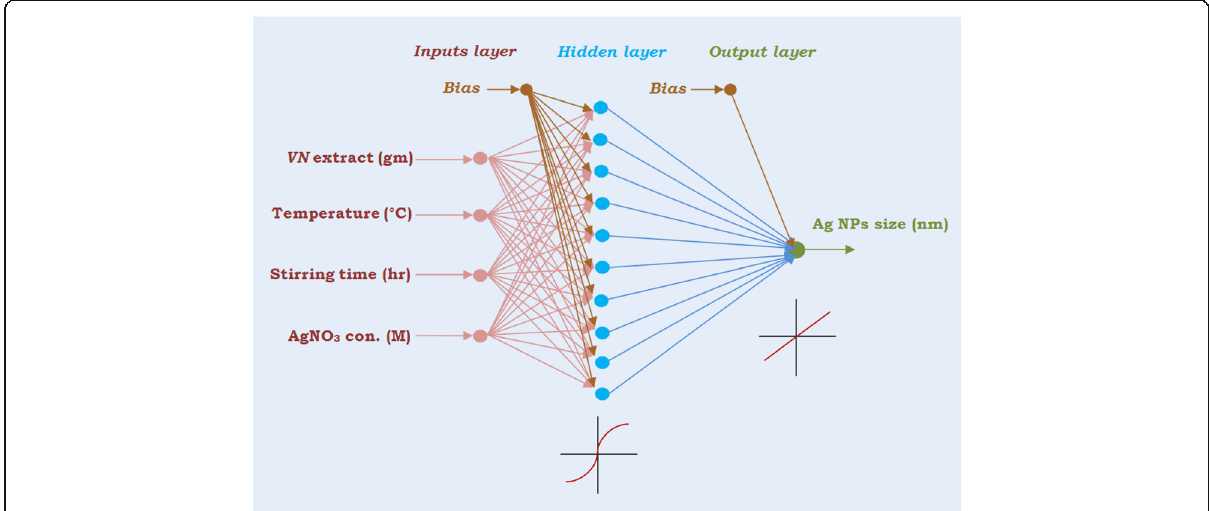
Fig. 8 An artificial neural network (ANN) for synthesis of AgNPs using V. negundo leave